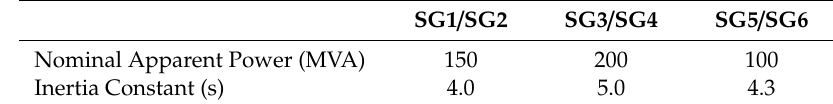
Table 1. Parameters of Synchronous generators.